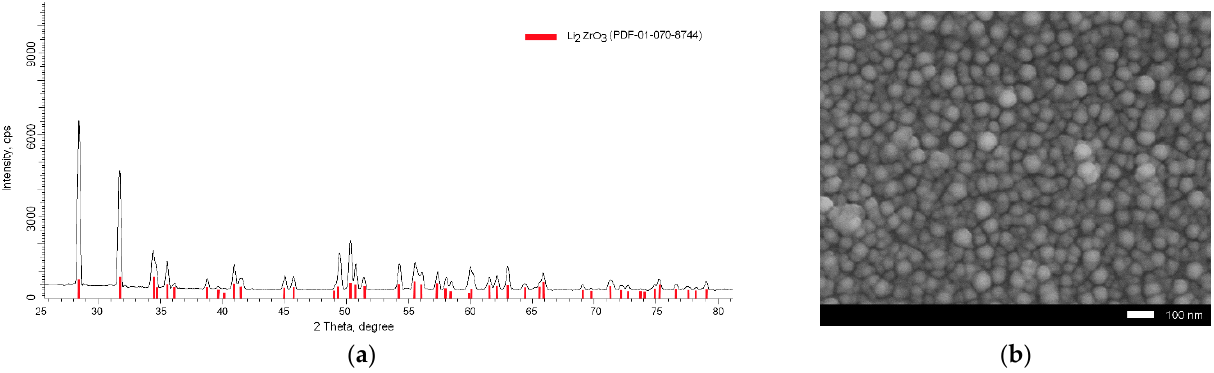
Figure 1. ( a ) X-ray diffraction pattern of the initial ceramic sample after sintering; ( b ) SEM - image of the initial sample surface after sintering and pressing.